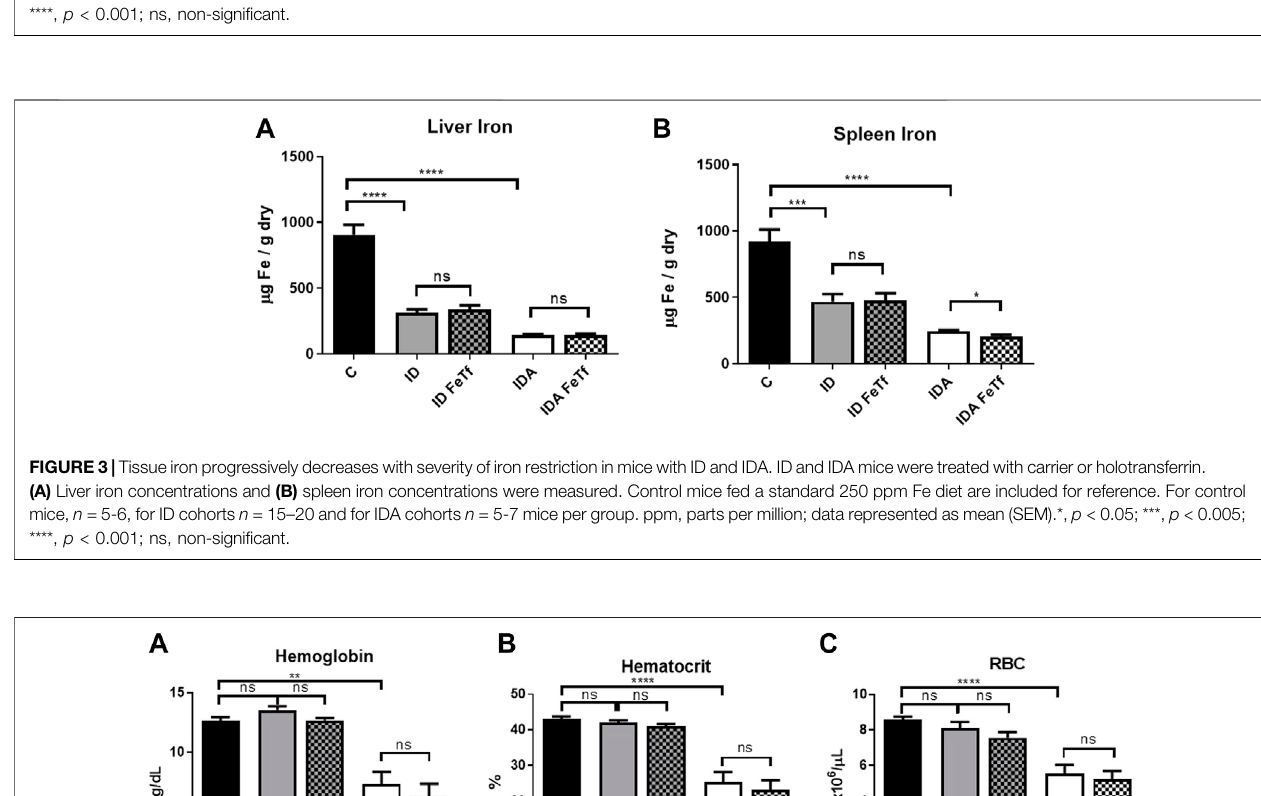
FIGURE 2 | Acute holotransferrin administration reverses the decrease in serum iron parameters in mice with ID but not IDA. ID and IDA mice were treated with carrier or holotransferrin and (A) serum iron and (B) transferrin saturation were measured. Control mice fed a standard 250 ppm Fe diet are included for reference. For controlmice, n =8,forIDcohorts n =13 – 15andforIDAcohorts, n =6micepergroup.ppm,partspermillion;datarepresentedasmean(SEM).*, p < 0.05;***, p < 0.005; ****, p < 0.001; ns, non-signi fi cant.